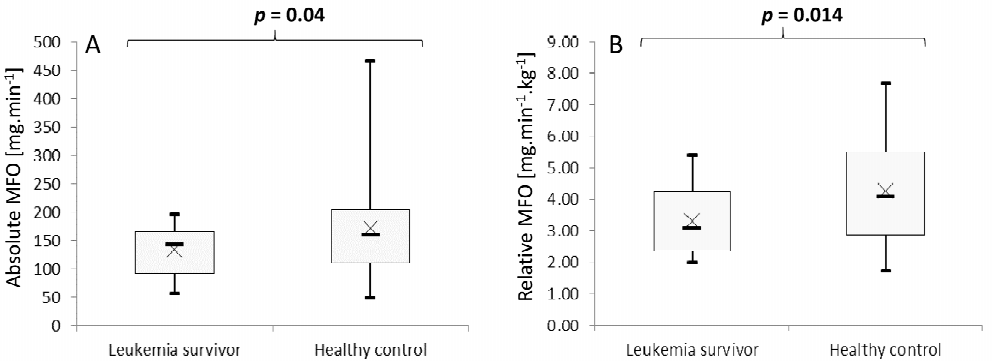
Figure 4. Comparison of absolute maximal fat oxidation ( A ) and relative maximal fat oxidation ( B ). Boxes represent interquartile ranges. Whiskers give minimum and maximum values. Data are means ( × ) and medians (–).